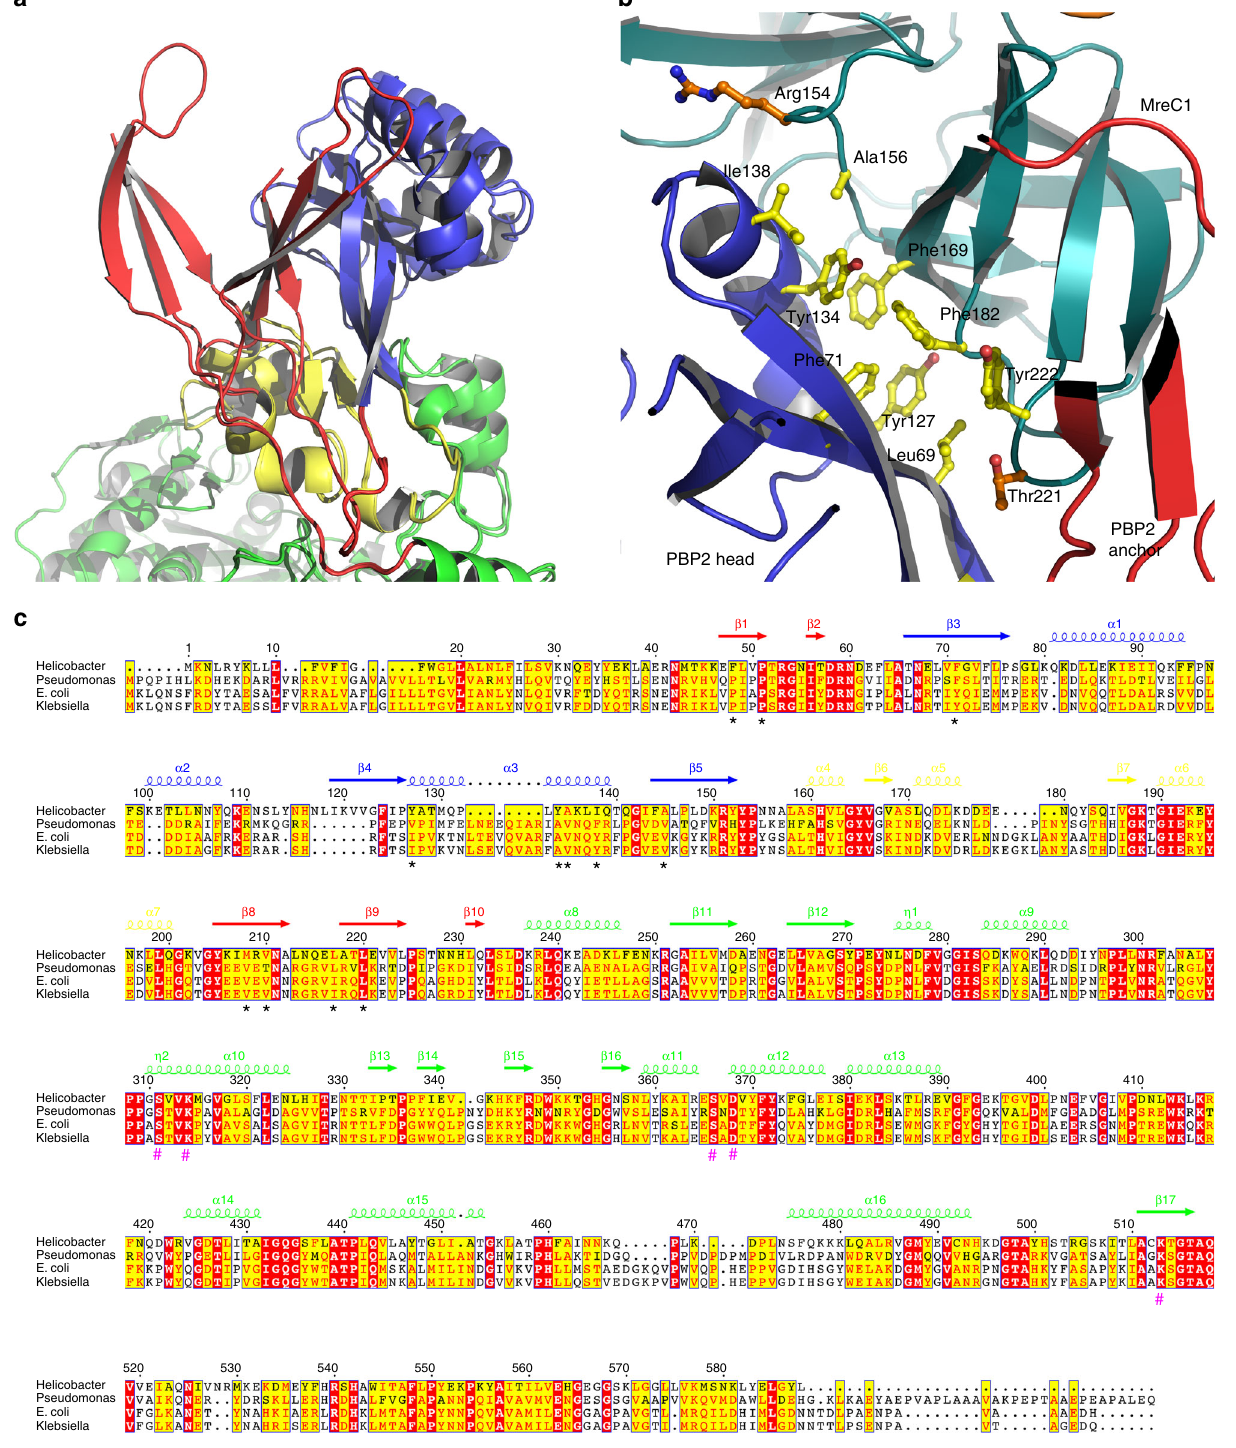
Fig. 2 MreC binding engenders opening of the N-terminus of PBP2. a Overlay of MreC-bound and unbound PBP2 structures, indicating movement of the anchor region (in red ). Opening of the N-terminal region of PBP2 exposes a hydrophobic region on the head that is complemented by a non-polar face on the surface of MreC ( b ), forming a hydrophobic zipper whose disruption hinders complex formation. c Structure-based sequence alignment between class B PBPs from H. pylori (this work), P. aeruginosa PAO1 G3XCV7, E. coli O157:H7 P0AD67, and K. pneumoniae A0A0W8ASI8 (UniProt codes). Head, anchor, linker, and TP are indicated in color above the sequence. Residues involved in interaction between head and anchor are indicated with black asterisks . Active site residues are indicated with hash tags . Figure generated with ESPRIPT